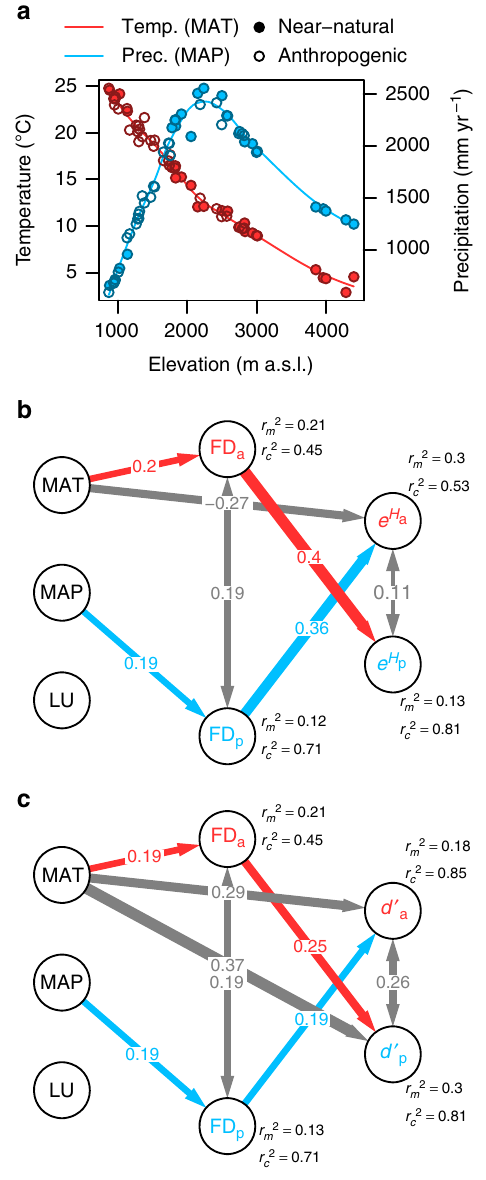
Fig. 3 Reciprocal bottom-up and top-down effects of functional diversity on the assembly of plant – animal mutualistic networks. a Variation in mean annual temperature (MAT [°C], red) and mean annual precipitation (MAP [mm yr − 1 ], blue), as well as land use (LU; fi lled circles, near-natural habitats; open circles, anthropogenic habitats) along the elevational gradient of Mount Kilimanjaro, Tanzania. The Bayesian hierarchical structural equation models in b , c tested for direct and indirect ‘ functional diversity ’ -mediated effects of mean annual temperature, mean annual precipitation and land use on ( b ) niche breadth (partner diversity, e H ) and ( c ) niche partitioning (complementary specialisation, d ′ ) of plants and animals via functional diversity of plant and animal communities (functional dispersion, FD; subscripts p and a for plants and animals, respectively). The lines in a represent loess smooth functions (degree = 2, span = 0.5) fi tted to the temperature and precipitation data across the elevational gradient. In b , c only paths that were supported by the Bayesian variable selection (2log e (Bayes factor) > 2) are shown (see Supplementary Table 2). Path colours depict bottom-up-mediated effects (blue), top-down-mediated effects (red) and direct abiotic effects (grey) on network structure. Grey double-headed arrows depict covariance terms that account for correlated errors due to common unmeasured sources of variance and due to reciprocal effects of functional diversity on the other trophic level. Path widths are proportional to standardised effect sizes. The values near the endogenous variables depict the marginal ( r 2 ) variance explained by fi xed factors only, as well as the conditional ( r c 2 ) variance explained by fi xed and random factors combined (see Methods for details) 70 . Sample sizes are n = 126 observations, n = 53 study sites and n = 3 obs site mutualism